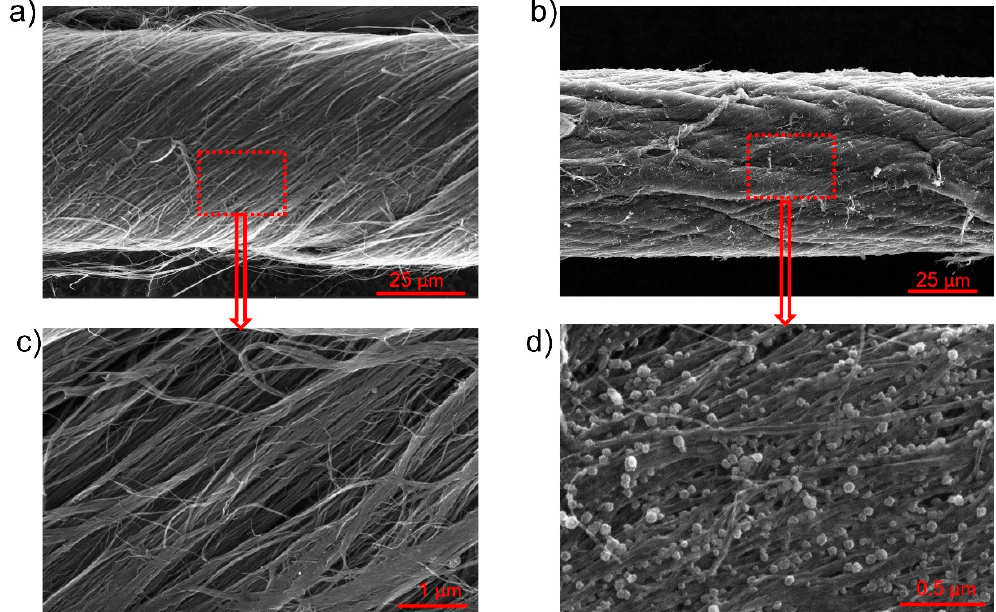
Figure 2. ( a ) SEM image of OPFCNT fiber; ( b ) SEM image of FeC 2 O 4 + FeOOH coated OPFCNT fiber; ( c ) Higher magnifi- cation image of ( a ); ( d ) Higher magnification image of ( b) .